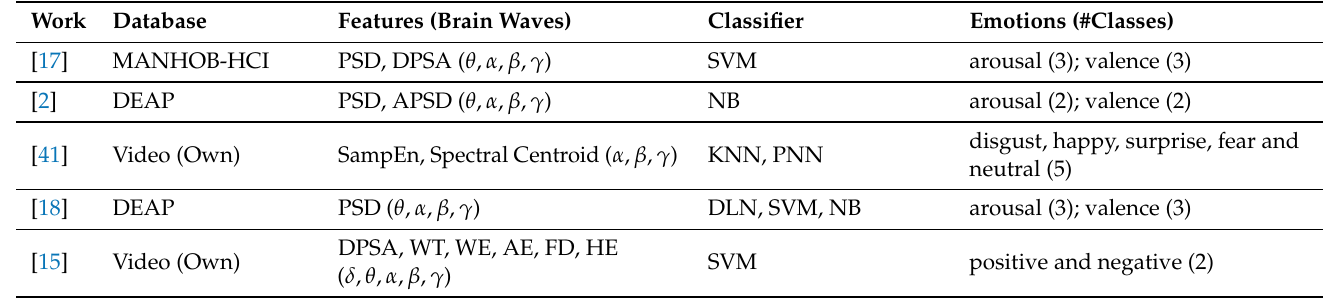
Table 1. A brief summary of the analyzed works and their main